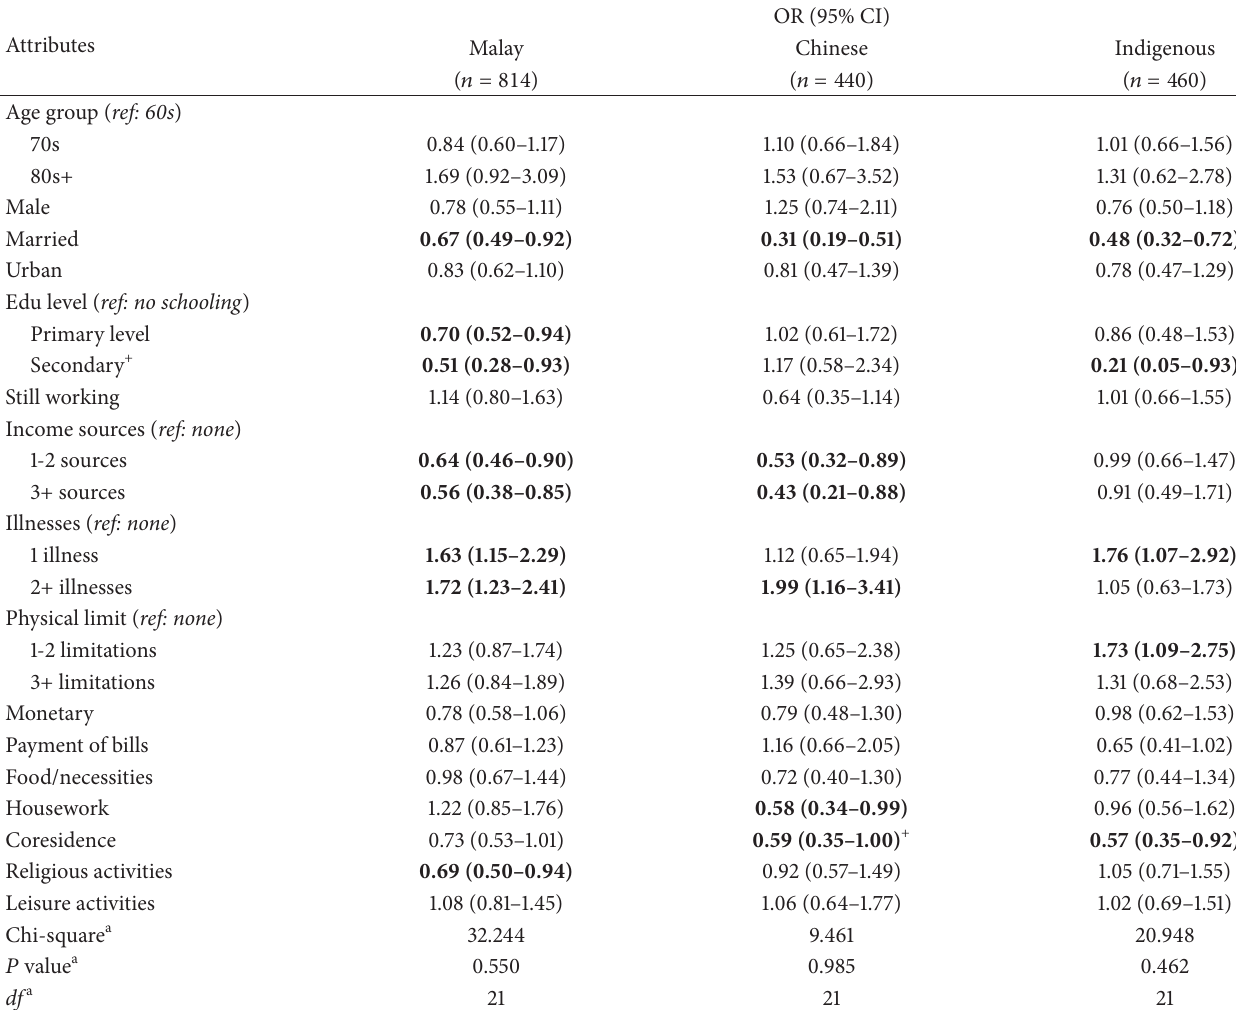
Table 5: Results of ordinal logistic regression for ethnic